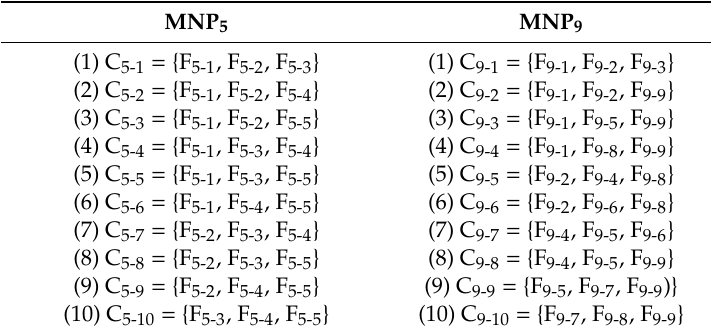
Table 1. Ten combinations of faults for an multivariate normal process with five quality variables (MNP 5 ) and an MNP with nine quality variables (MNP 9